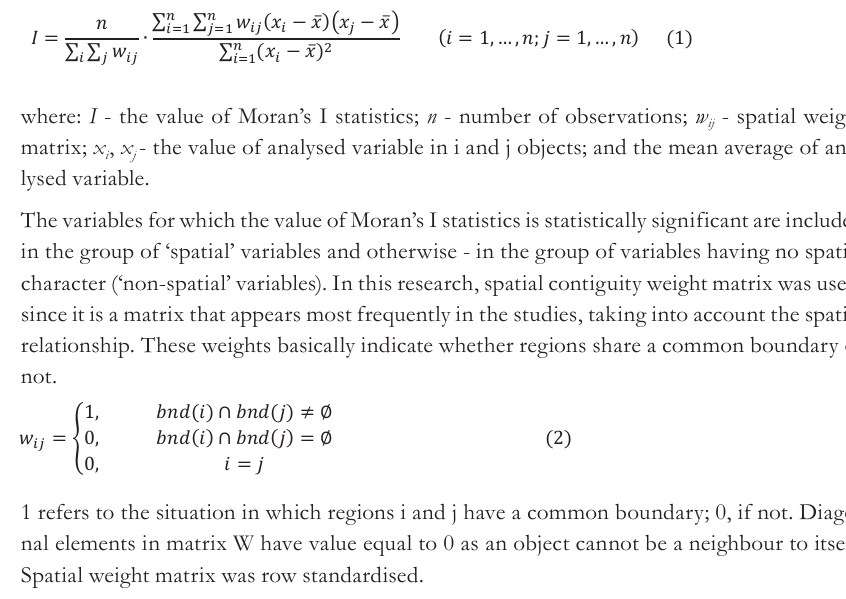
where: I - the value of Moran’s I statistics; n - number of observations; w